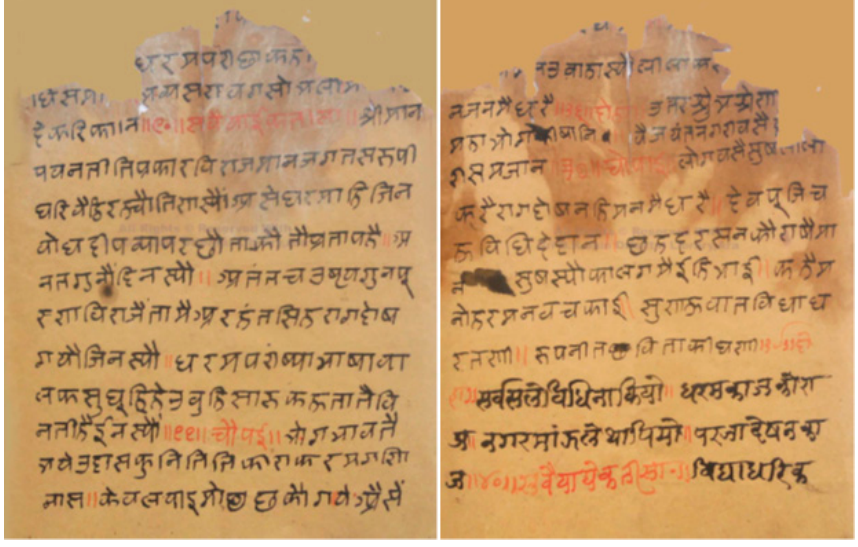
Figure 6. Dharmapar ī k ṣ ā by Manohard ā s, Jain Siddh ā nt Bhavan n. Da-021-28. 42 Figure 6. Dharmapar¯ıks. ¯a by Manohard¯as, Jain Siddh¯ant Bhavan n. Da-021-28.